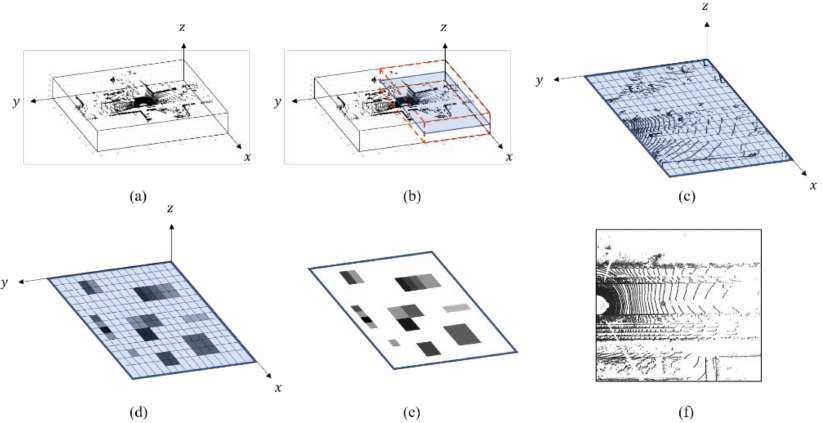
Figure 4. Process of conversion to height map: ( a ) 3D PCD, ( b ) PCD extraction from the RGB camera’s point of view, ( c ) pixelization, ( d ) single channel encoding, ( e ) scaling by height value, and ( f ) converted height